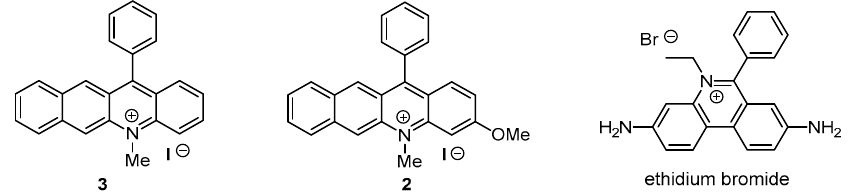
Figure 1. Compounds whose DNA visualization ability was tested.